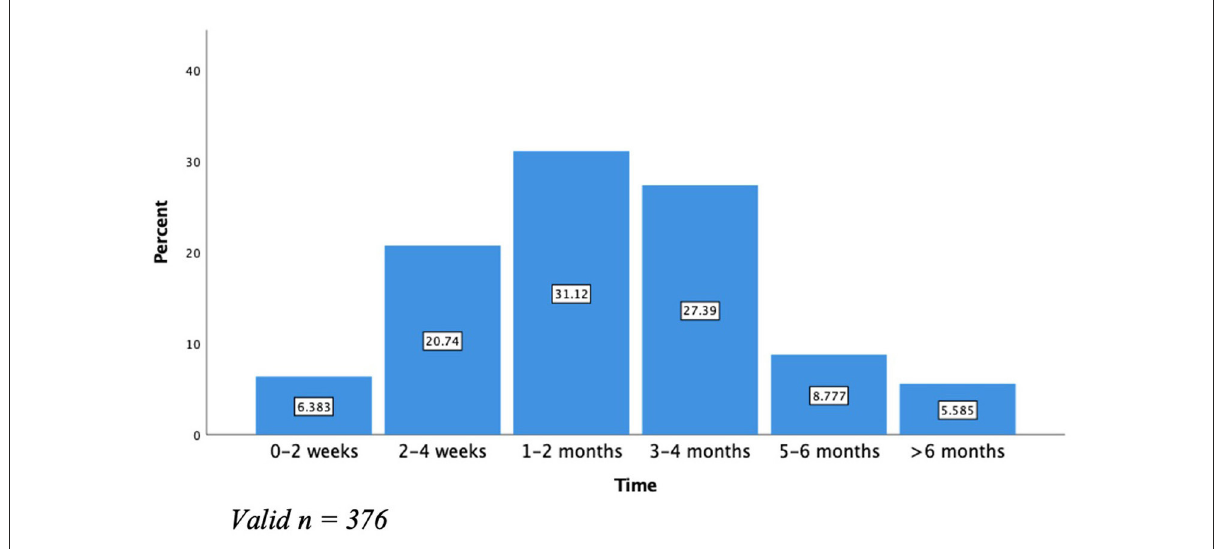
FIGURE2 Wait times for perinatal mental health treatment. Valid n = 376